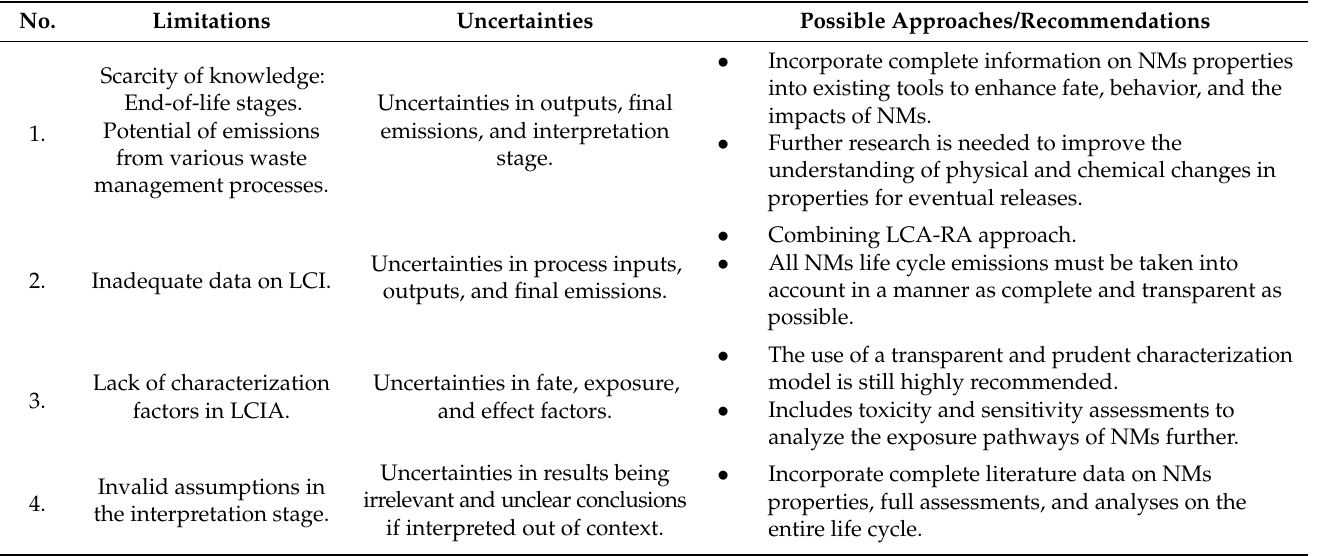
Table 2. Limitations and recommendations to LCA practitioners in the field of